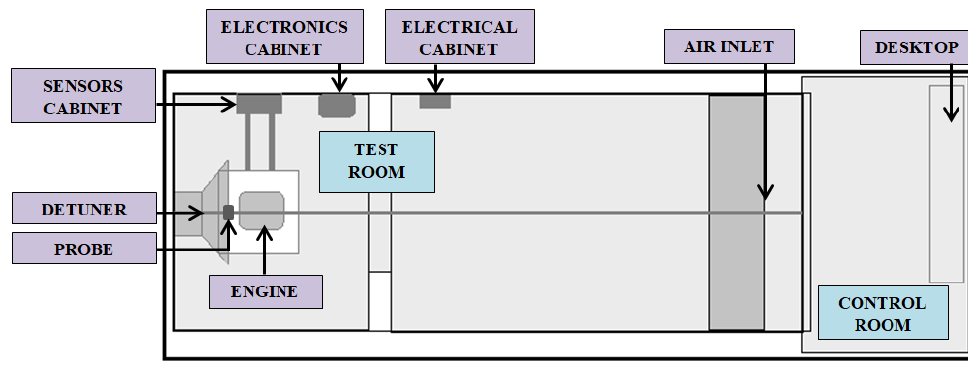
Figure 2. Scheme of the engine test cell [36].